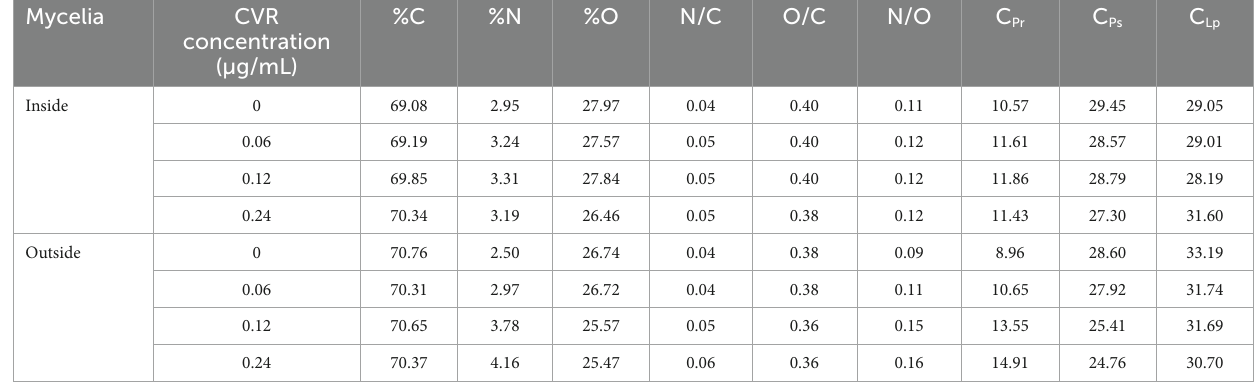
TABLE 1 Surface chemical composition of mycelia of A. alternata treated with CVR at 0, 0.06, 0.12, and 0.24 μl/ml, measured by XPS.